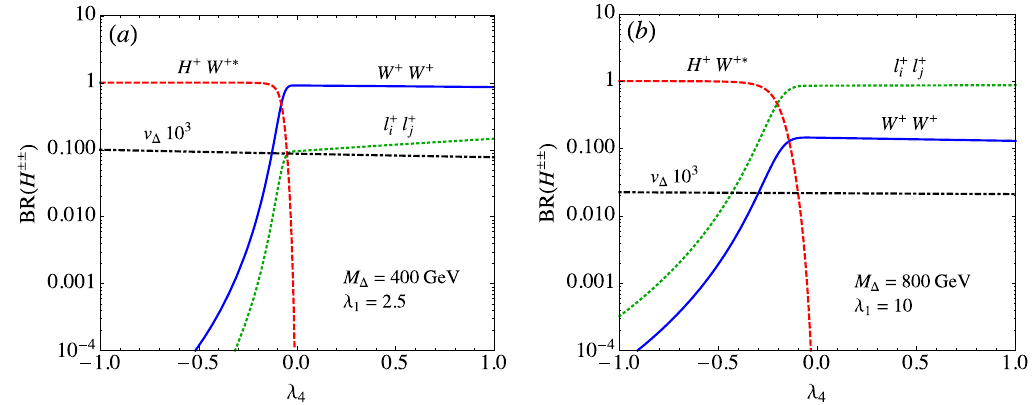
Figure 11 . BR of the H ++ decay as a function of (cid:21) 4 , where (a) M (cid:1) = 400 GeV and (cid:21) 1 = 2 : 5 are (cid:12)xed and (b) M (cid:1) = 800 GeV and (cid:21) 1 = 10 are used. The dot-dashed line is for v (cid:1)